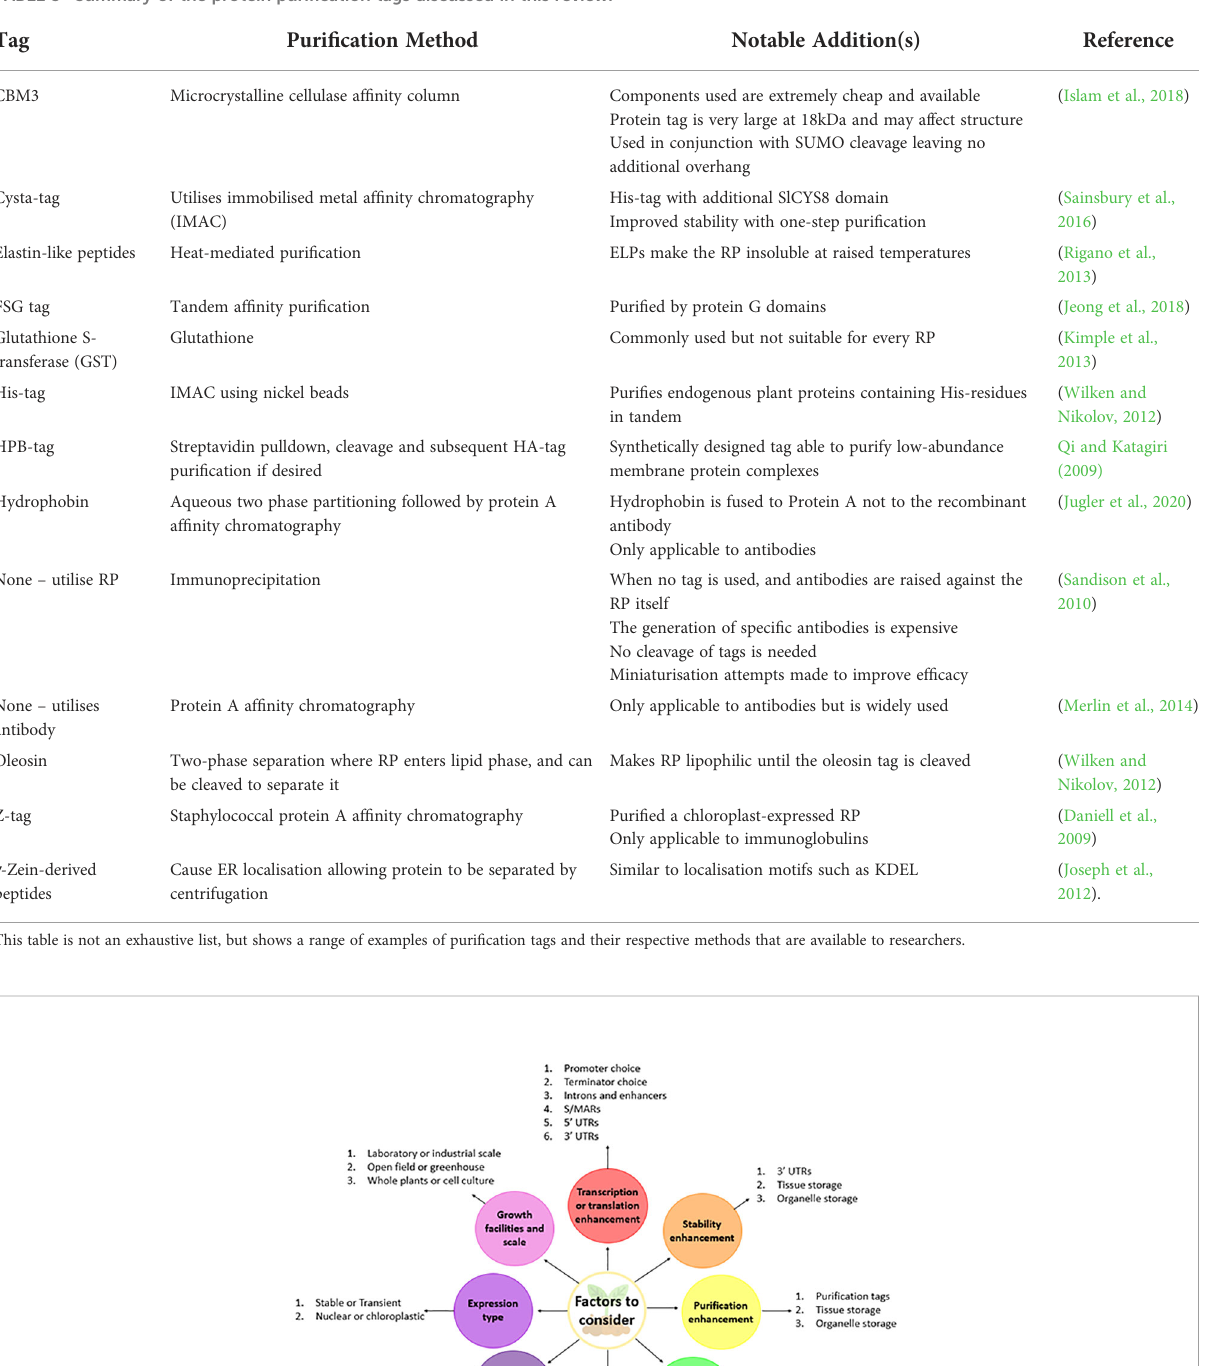
TABLE 3 Summary of the protein puri fi cation tags discussed in this review.